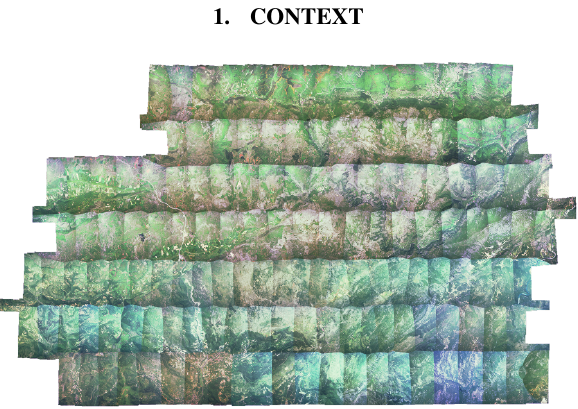
Figure 1. Orthophotomosaic without radiometric correction.